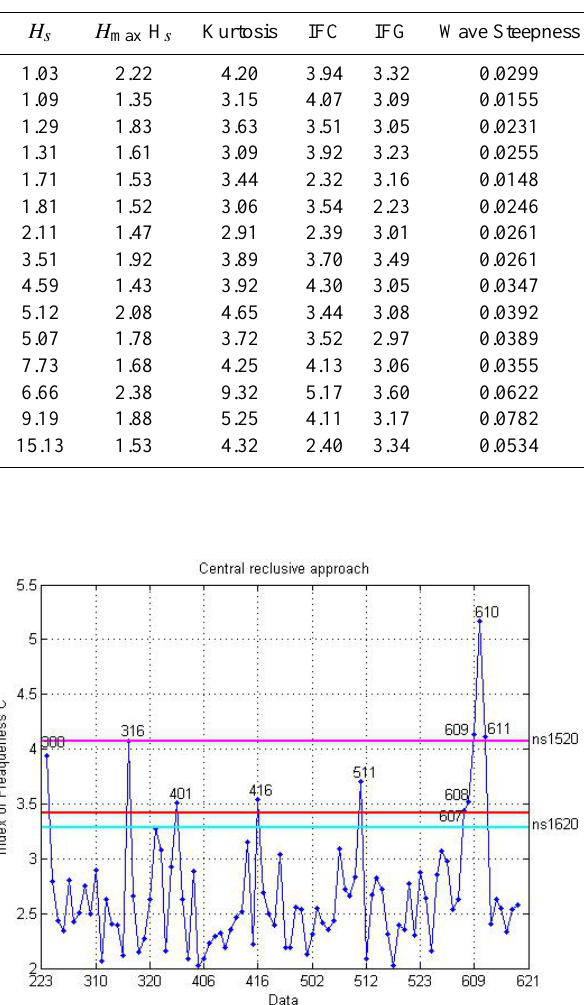
Table 1. Corresponding parameters and indices for the perceived freaque wave cases.